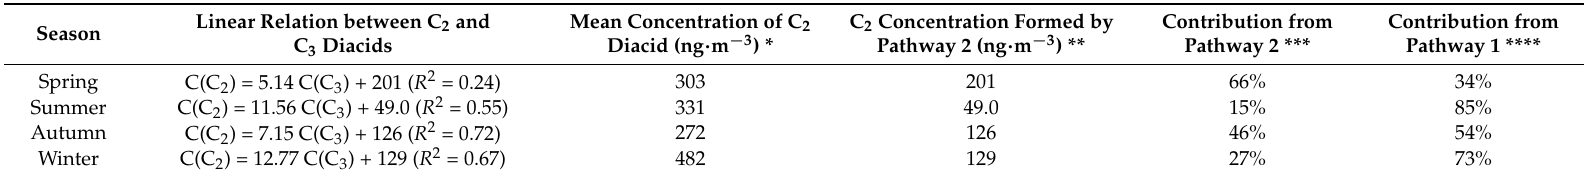
Table 4. Contribution of different pathways to the formation of C 2 diacid according to the linear relation between C 2 and C 3 diacids in the PM 10 aerosols of Huangshi, Central